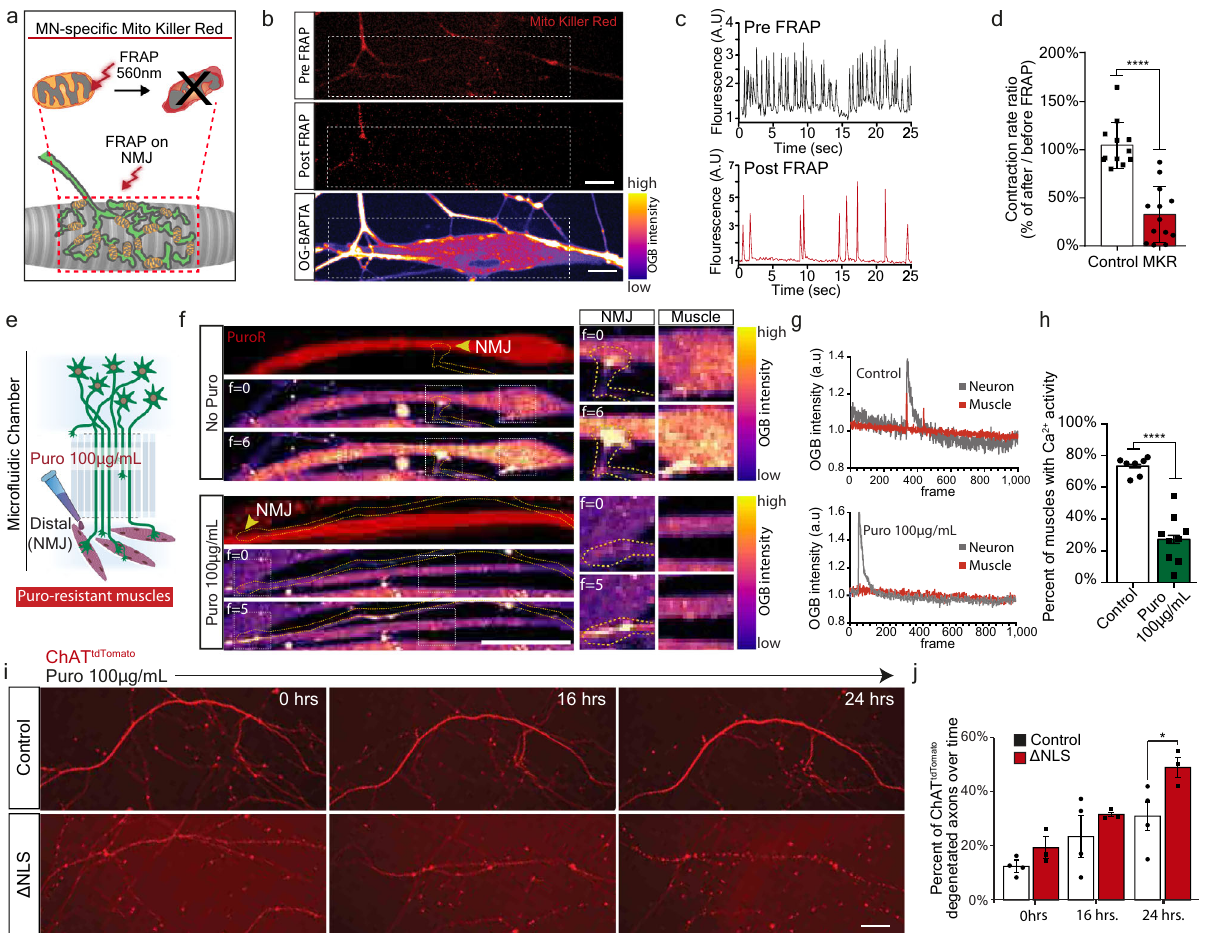
Fig. 6 NMJ function is dependent on mitochondria and local synthesis, and their absence leads to decreased NMJ activity and axon degeneration. a Schematic illustration of Mito-Killer-Red (MKR) experimental setup, used for speci fi cally targeting oxidative stress to NMJ mitochondria. b Images of MKR in NMJ pre-synapse before and after bleach (white line = bleached region). Lower panel indicates post-synaptic muscle labeled with calcium indicator Oregon-Green-BAPTA (OGB). Scale bar = 10 µ m. n = 13,12 NMJs from 3 independent experiments. c , d Representative OGB time-trace of OGB indicating muscle contraction ( c ) and quanti fi cation ( d ) of contraction ratio before and after MKR bleaching. As control, ChAT::tdTomato-expressing axons were bleached instead of MKR-expressing axons. n = 13,12 NMJs from 3 independent experiments. Data are presented as mean values ± SD. Unpaired- t -test, two-sided. **** p < 0.0001. e Schematic illustration of experimental procedure for puromycin local protein synthesis inhibition in NMJ pre-synapse using puromycin resistant muscles. f Left panel: Time-series images of OGB-labeled co-cultures treated, or not with puromycin in NMJ compartment. Right panel: Demonstration of paired axon-muscle calcium activity only in control NMJs and its absence upon puromycin application. Scale bar = 20 µ m. n = 7,9 MFCs from 3 independent experiments. g Time traces of OGB in pre-synaptic neurons and post-synaptic muscles in control (upper plot), and in puromycin-treated (lower plot) cultures. h Quanti fi cation of the percent of innervated and contracting muscles after puromycin application. n = 7,9 MFCs from 3 independent experiments. Data are presented as mean values± SD. Unpaired- t -test, two-sided. **** p < 0.0001. i Images and j quanti fi cation of the percent of degenerating axons in TDP Δ NLS and control MN cultures following 16 and 24 h of puromycin treatment. Scale bar = 50 µ m. n = 4,3 MFCs from 3 independent experiments. Data are presented as mean values± SD. Two-way-ANOVA with Holm-Sidak correction. * p = 0.0407. a.u stands for arbitrary units. Source data are provided as a Source Data fi